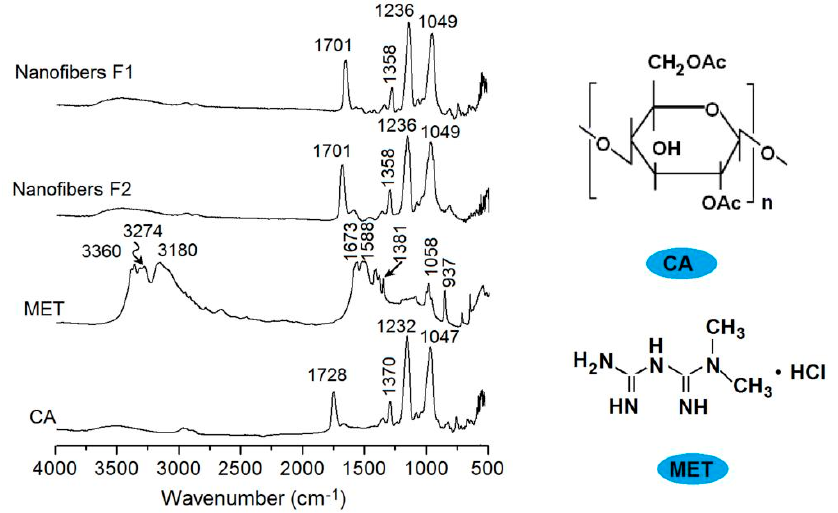
Figure 7. FTIR spectra of CA, MET, and their core–sheath nanofibers F1 and F2, and the molecular formula of CA and MET.